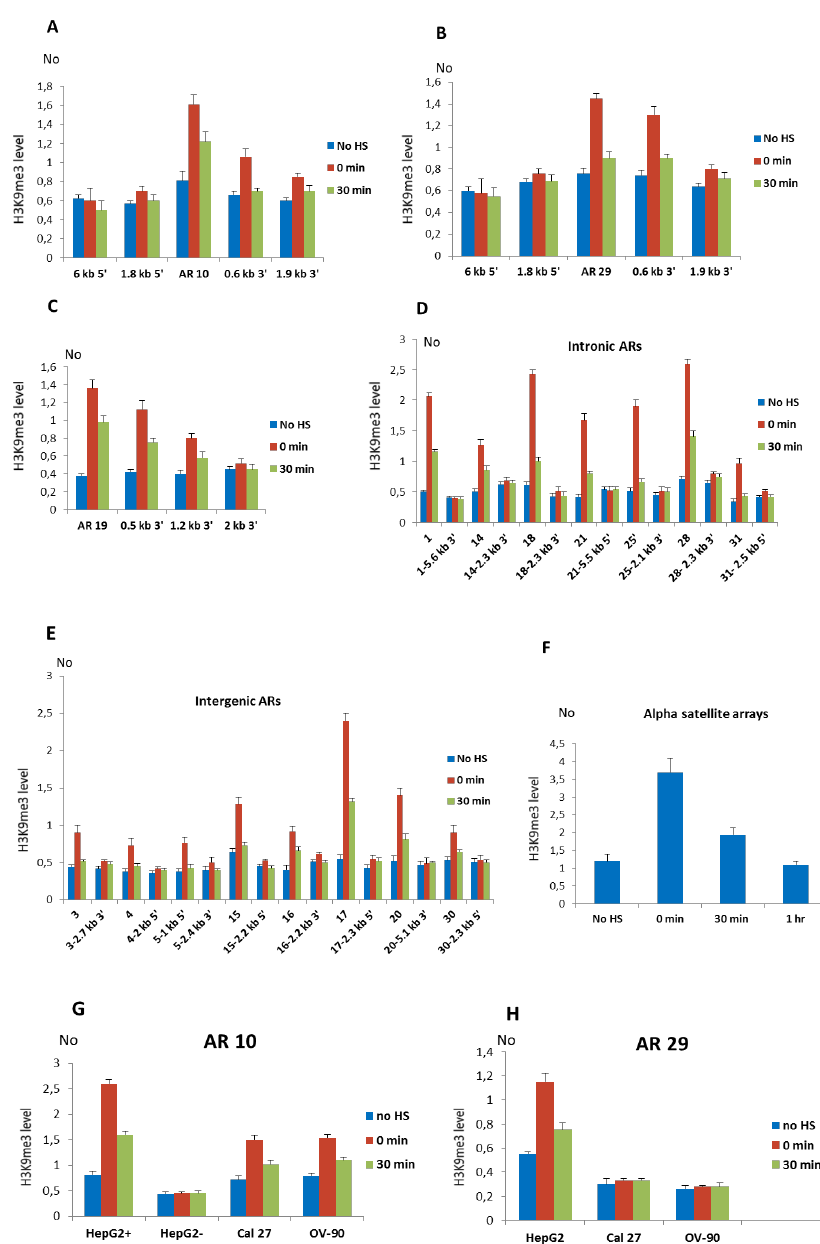
Figure 2. The level of H3K9me3 at alpha satellite repeats (ARs) and their proximal regions. ( A ) The profiles of H3K9me3 distribution in MJ90 hTERT cells at alpha repeat 10, ( B ) alpha repeat 29, ( C ) alpha repeat 19, and at their neighboring regions positioned 0.5–6 kb to each of the AR. ( D ) H3K9me3 level at intronic alpha satellite repeats No 1, 14, 18, 25, 21, 28, 31, and ( E ) intergenic alpha satellite repeats No 3, 4, 15, 16, 17, 20, and 30 as well as at the region 1 kb 5 (cid:48) to intergenic AR No 5. In addition, H3K9me3 level at the regions positioned 2–6 kb from each of the alpha repeat, either at 5 (cid:48) or 3 (cid:48) site is shown. ( F ) H3K9me3 level at tandemly arranged alpha satellite repeats characteristic for heterochromatin and at ( G ) AR 10 in intron of NR3C 1 gene in Cal 27 and OV-90 cells as well as in HepG2 cells on allele with (HepG2 + ) and without AR (HepG2-), ( H ) AR 29 in intron of ZNF675 gene in HepG2 cells as well as in the corresponding intron region without alpha satellite repeat in Cal 27 and OV-90 cells. H3K9me3 levels were measured by ChIP coupled by quantitative real-time PCR at standard conditions (no HS), immediately after 2 h of HS (0 min), at 30 min (30 min) and 1 h of recovery. No value was normalized using No value of input fraction and represents the H3K9me3 level. Columns show average of three independent experiments and error bars indicate the standard